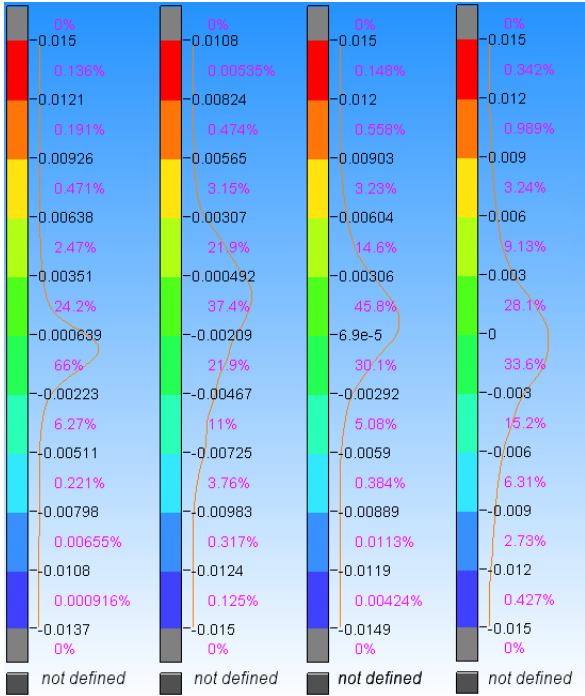
Figure 11 - Histograms of the comparisons. Starting from the left are reported the results between the laser model and: iPhone, Samsung, GoPro and Contour.